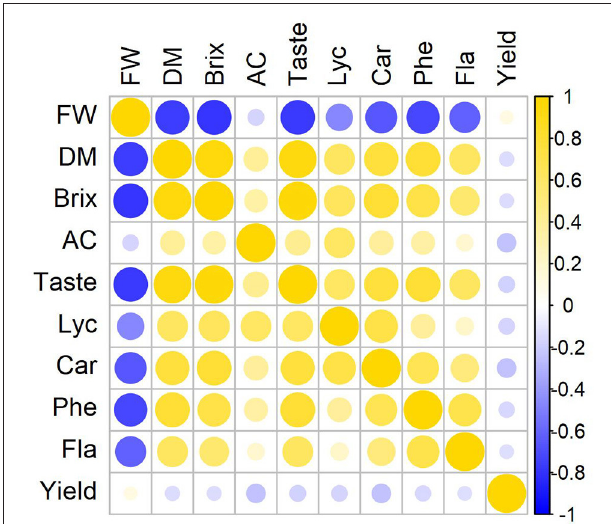
FIGURE 3 | Correlations between the fruit parameters of tomatoes.